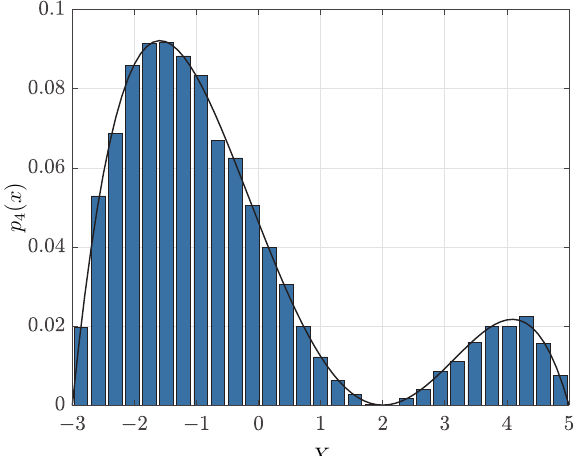
Figure 3. The PDF (66) and the empirical histogram for 10 4 generated random samples.